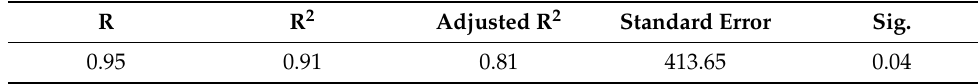
Table 7. Summary of models for business sites.